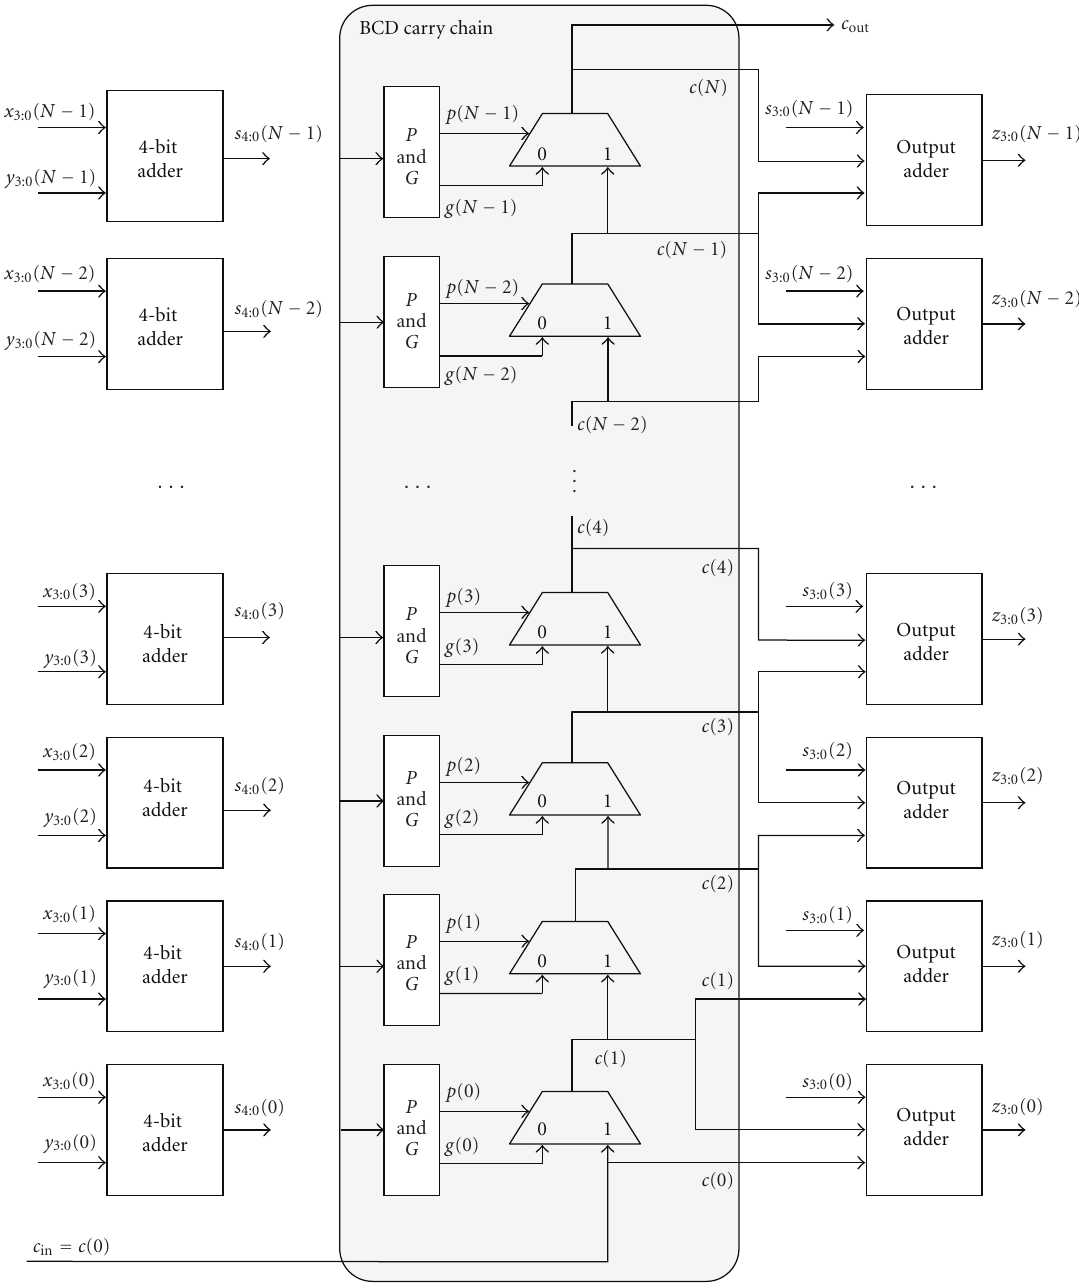
Figure 10: FPGA implementation of an N -digit BCD